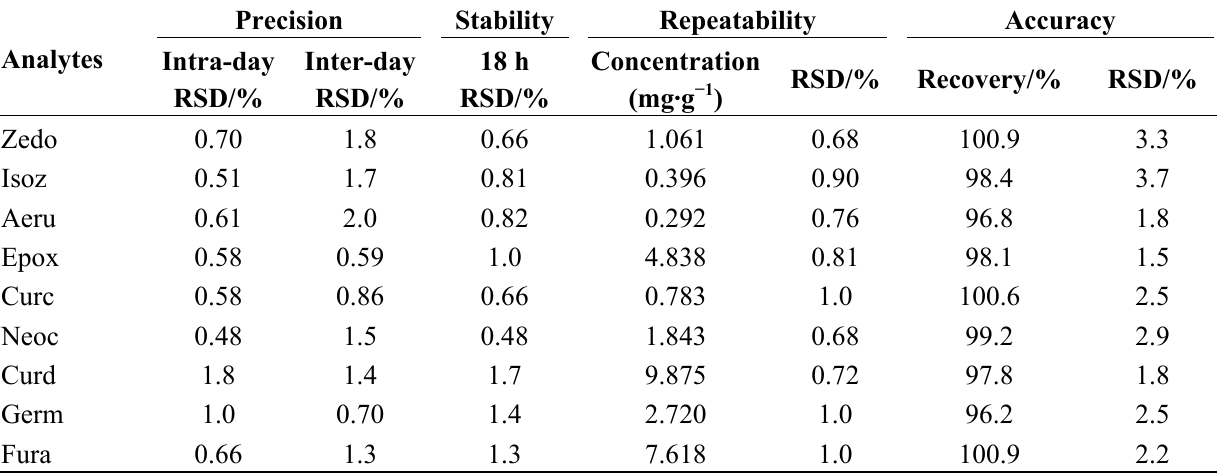
Table 2. Precision, stability, repeatability and recovery of investigated